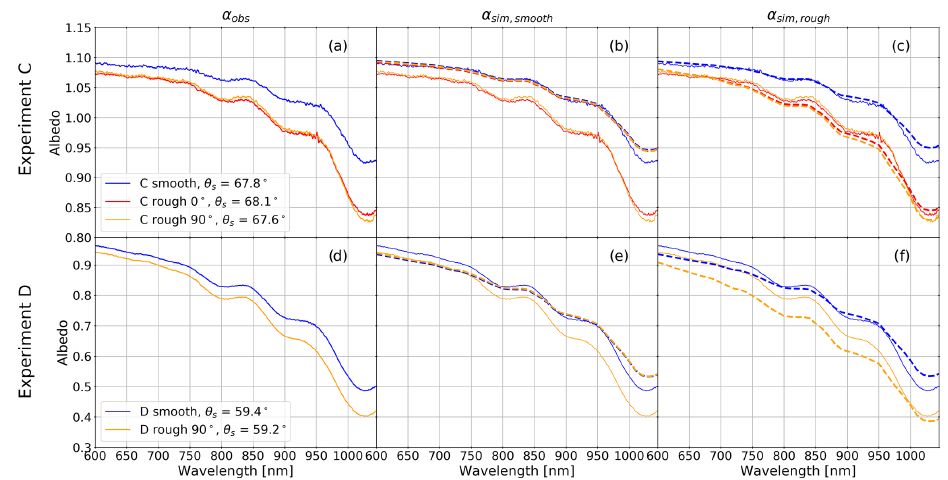
Figure 6. Spectral albedo variations for experiment C at θ s ∼ 68 ◦ with (a) α obs , (b) α obs (solid lines) and α sim , smooth (dashed lines), and (c) α obs (solid lines) and α sim , rough (dashed lines). Red lines represent the C rough 0 ◦ surface, yellow lines the C rough 90 ◦ surface and blue lines the C smooth surface. Panels (d) , (e) and (f) are the same but for experiment D at θ s ∼ 59 ◦ . Orange lines represent the D rough 0 ◦ surface and blue lines the D smooth